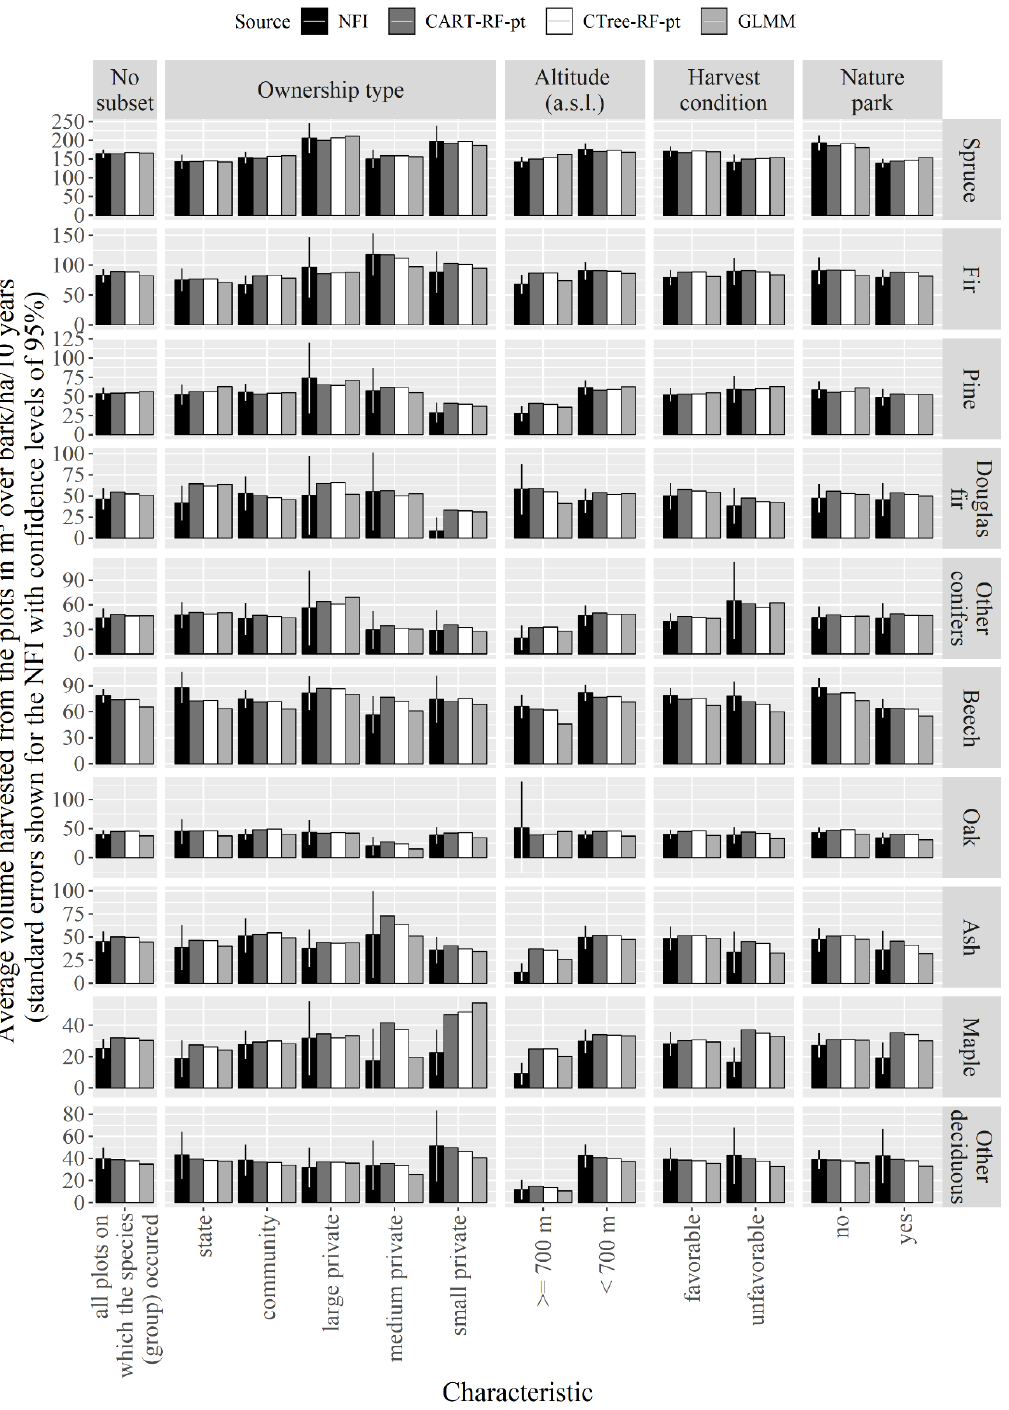
Figure A5. Comparing 2002–2012 predicted average harvested volumes (tree-level models only) from plots on which harvests occurred according to the national forest inventory (NFI) for species (groups) and selected data subsets. Harvested volumes refer to the average of the plots included in the respective test set subsample on which the species (group) occurred. The reference year for the diameter at breast height (DBH) classes and harvested volumes was 2007 (CART: Classification and regression tree; CTree: Conditional inference tree; RF: Random forest; pt: variation that used plot- and tree-level attributes; GLMM: Generalized linear mixed model; a.s.l.: above sea level).